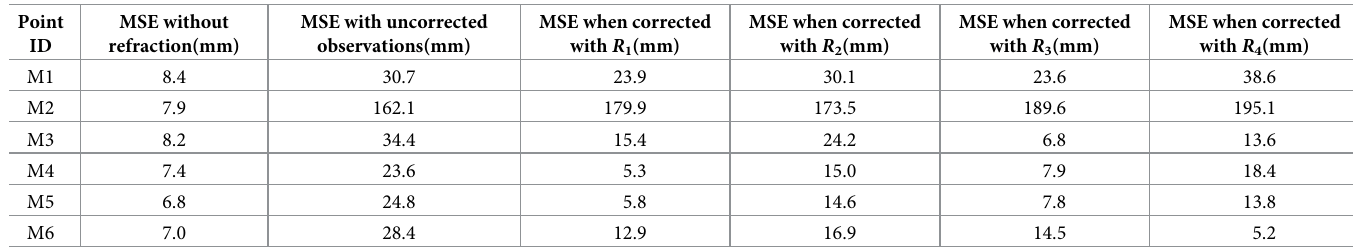
Table 3. Plane displacement accuracy comparison with coordinate correction. Point